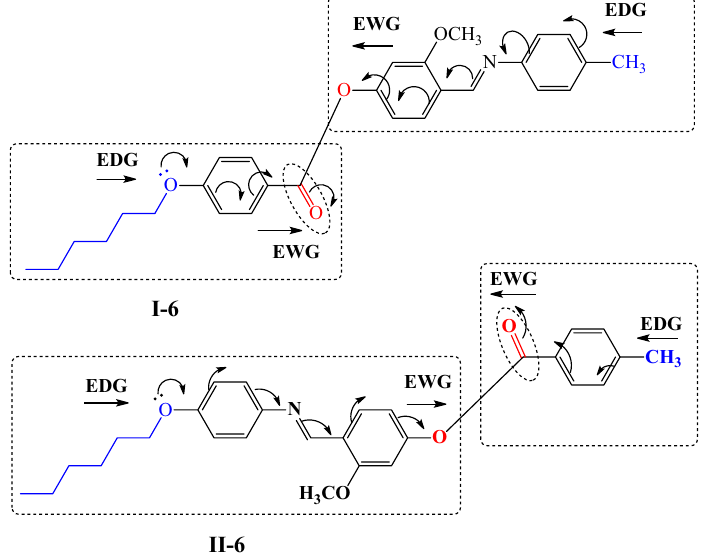
Figure 5. Schematic conjugation of compounds I-6 and II-6 ; Electron withdrawing group (EWG); Electron donating group